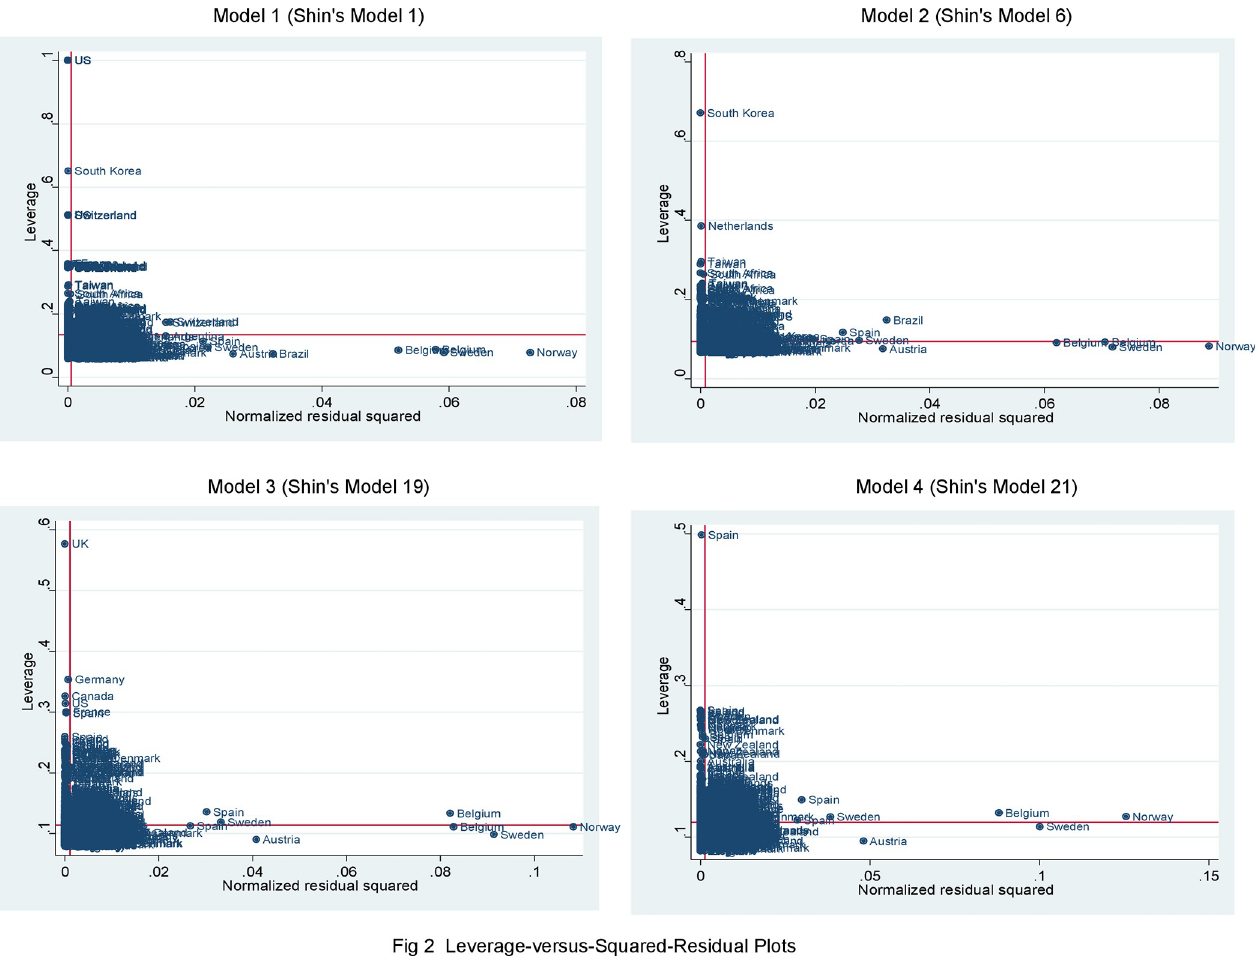
Fig 2. Leverage-versus-squared-residual